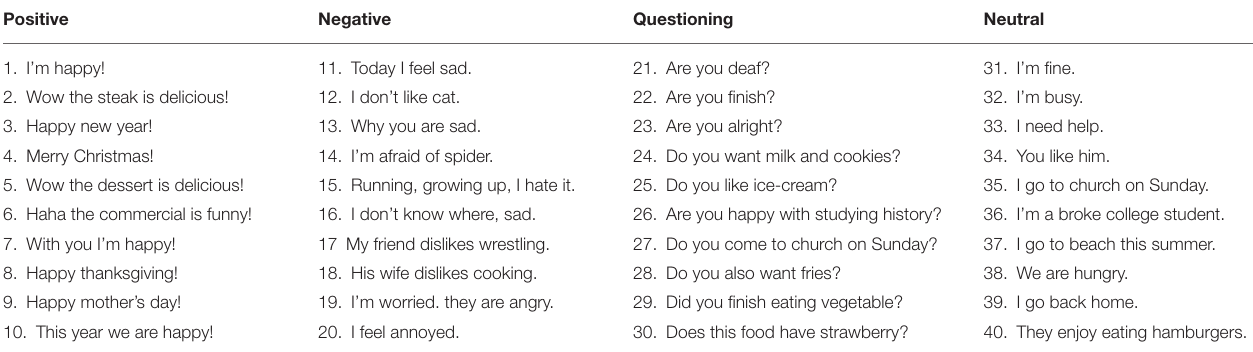
TABLE 1 | Forty commonly used American sign language sentences.